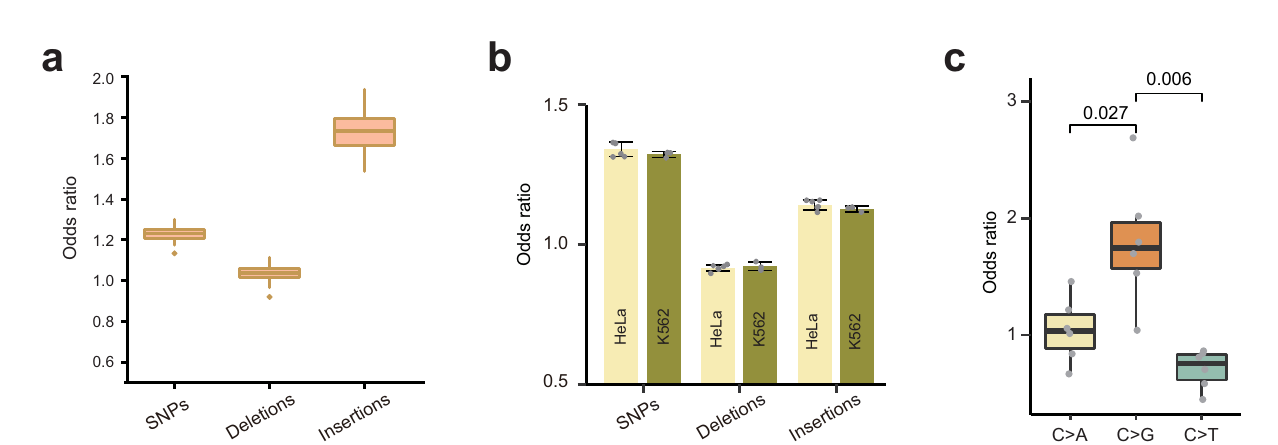
Fig.3|LandscapeofallAPsitesinthemousegenome.a GloballevelsofAPsites. b GloballevelsofSSBs. c OverlapbetweenAPsitesandrepeats. d Overlapbetween AP sites and genomic elements. The dELS, pELS, and PLS represent candidate cis - regulatory elements with distal enhancer-like, proximal enhancer-like and pro- moter signatures, respectively. e Distribution of the template vs. nontemplate ratios for the AP sites found in the indicated elements. f Overlap between the AP sites and satellite repeats. g Overlapbetween the APsites and exons. h Odds ratios ofoverlapbetweenAPsitesandtheindicatedelements. i DensityofAPsitesonthe template strands of the indicated elements. j Density of AP sites on the non- template strands of the indicated elements. k Box plots of the template vs. non- template ratios for the AP sites located at the indicated elements. Genes were strati fi ed by expression level in each sample, and the overlap with the AP sites was calculated for each stratum in each sample ( h – k ). Data are presented as mean